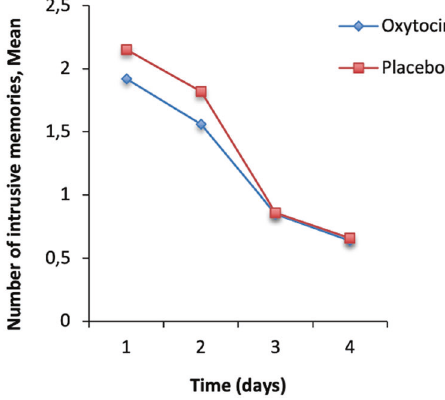
Fig. 2 Mean number of intrusive memories in the oxytocin and placebo group over 4 days. Points are